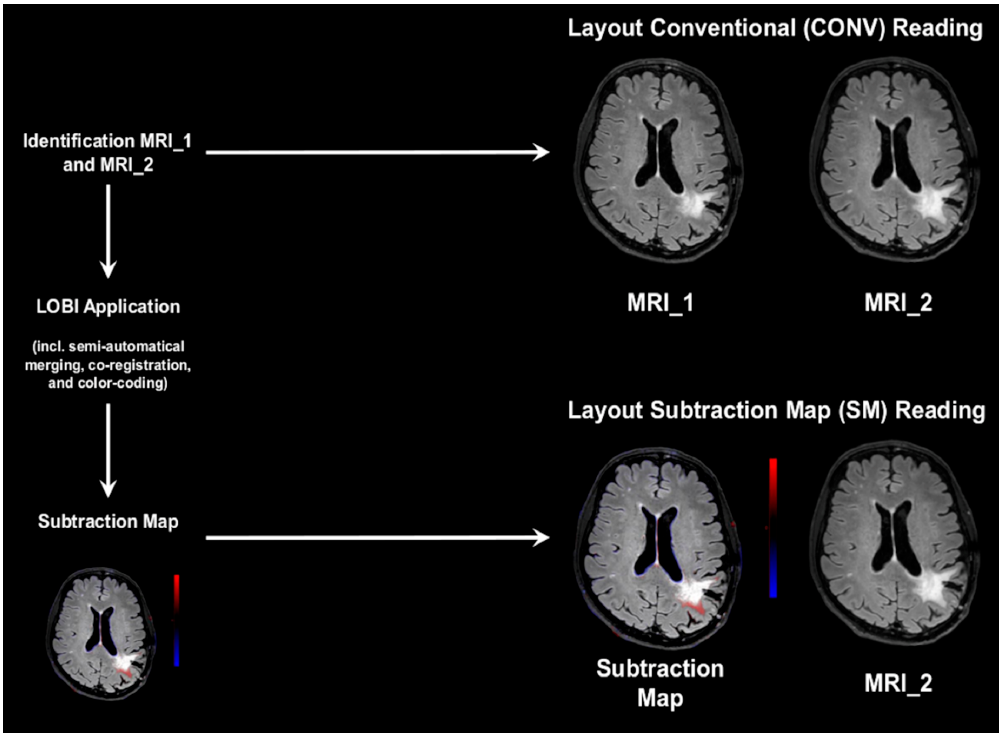
Figure 1. Schematic illustration of image preparation and layouts. Image layouts were generated for conventional (CONV) reading and subtraction map (SM) reading, respectively. For CONV reading, the layout depicted the fluid attenuated inversion recovery (FLAIR) sequences of MRI_1 and MRI_2 alongside each other, and the readers performed standard visual reading of the image pairs. For SM reading, a color-coded SM was created first based on the FLAIR sequences of MRI_1 and MRI_2. The layout for SM reading included the individual SM alongside with MRI_2. In the SMs, new or progressive lesions were shown in red, and regressive lesions were depicted in blue.